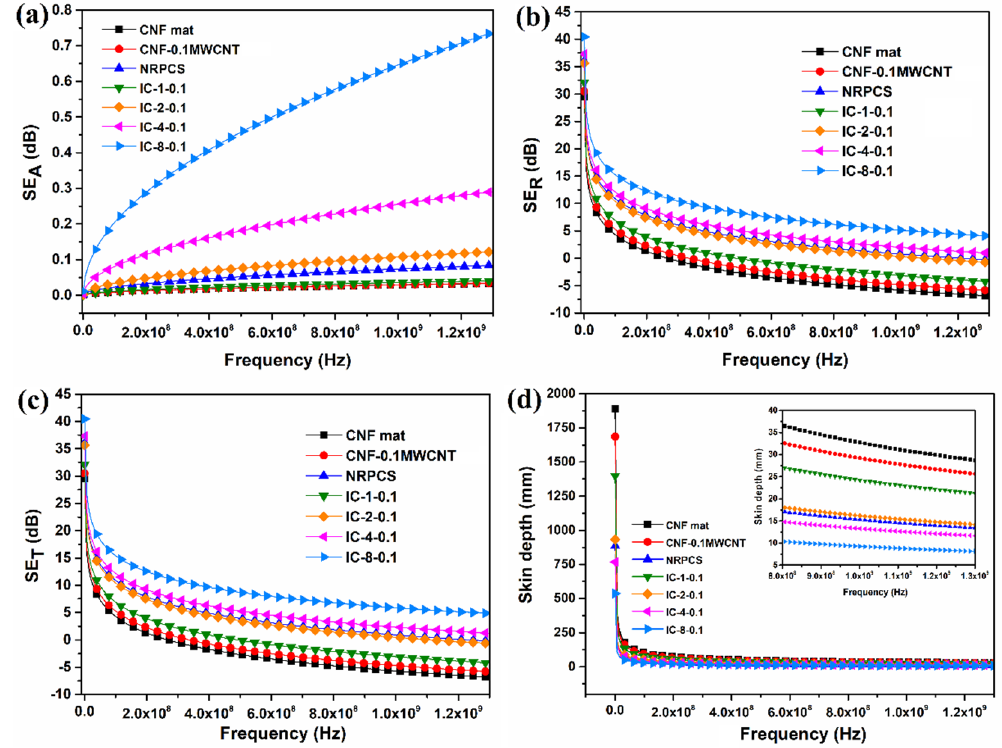
Figure 9. Calculated EMI SE versus frequency. ( a ) SE A ; ( b ) SE R ; ( c ) SE T of CNF mat, 0.1 wt.% MWCNT filled carbon nanofiber mat, NRPCS and interlayered composites formed by different number of layers of 0.1 wt.% MWCNT filled carbon nanofiber mats; and, ( d ) Skin depth dependence with respect to frequency. The inset in ( d ) shows a zooming view of skin depth at higher frequencies (0.8–1.3 GHz).